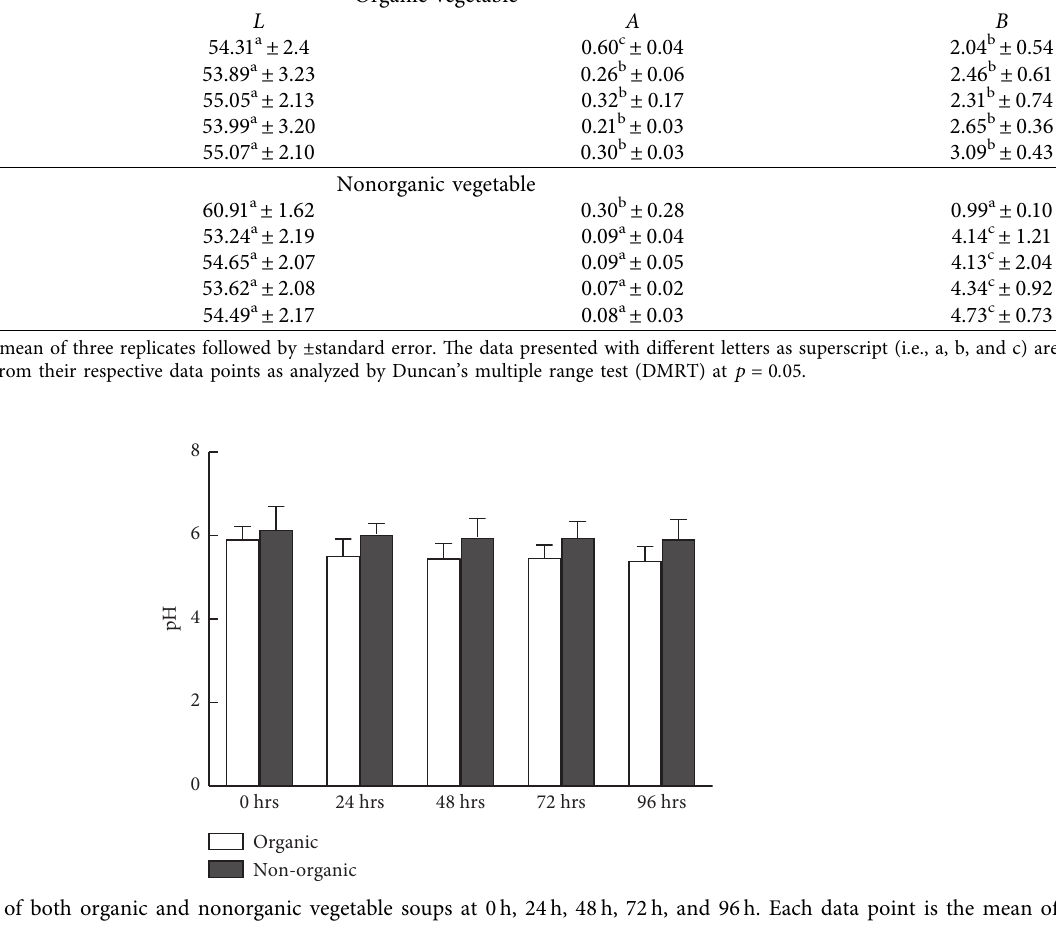
Table 1: Colour measurement of both organic and nonorganic vegetable soups at 0, 24, 48, 72, and 96 hours of storage. Colour measurement Organic vegetable